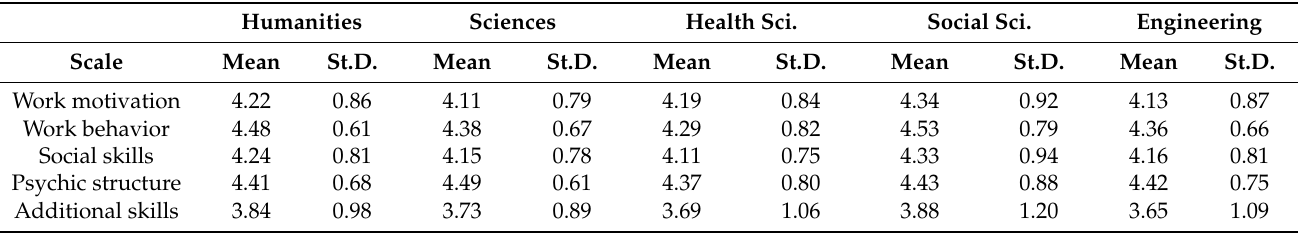
Table 11. Means and standard deviations (St.D.) of the overall answers of the different scales of the questionnaire when the sample is differentiated by area of knowledge.